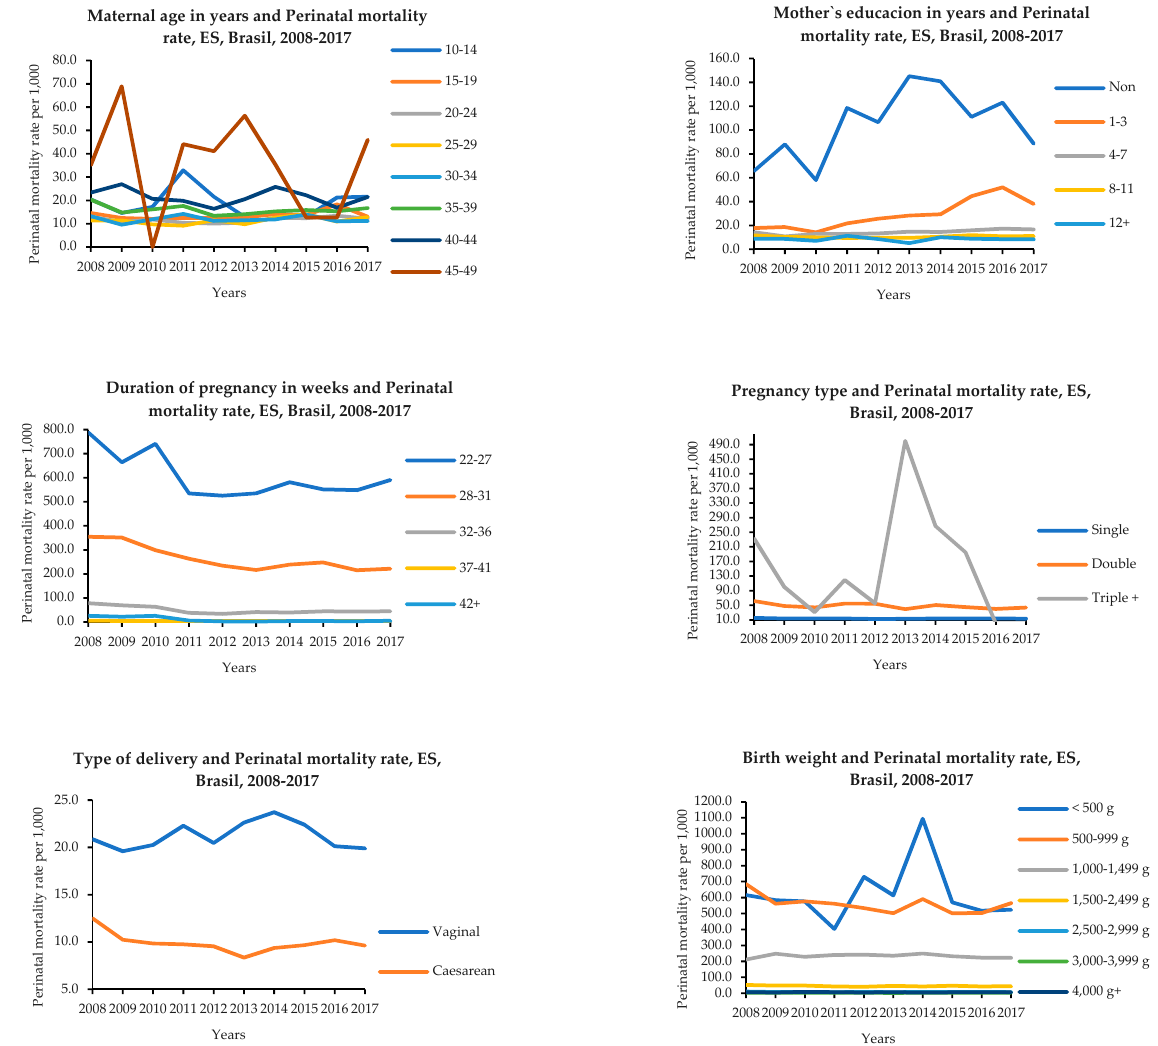
Figure 3. Factors associated with the trend in perinatal mortality. Espírito Santo, Brazil, 2008–2017. Source: MS/SVS/CGIAE—Sistema de Informações sobre Mortalidade (SIM) e DASIS—Sistema de Informações sobre Nascidos Vivos (SINASC), 2021.